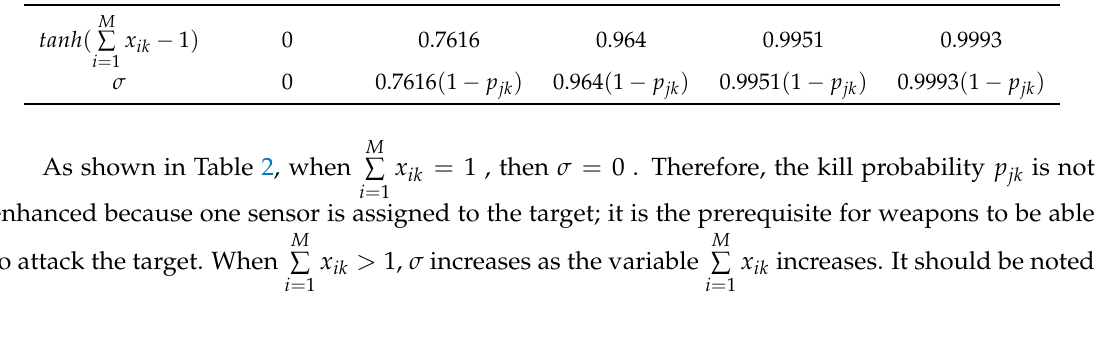
M ∑ x ik in [1, i = 1